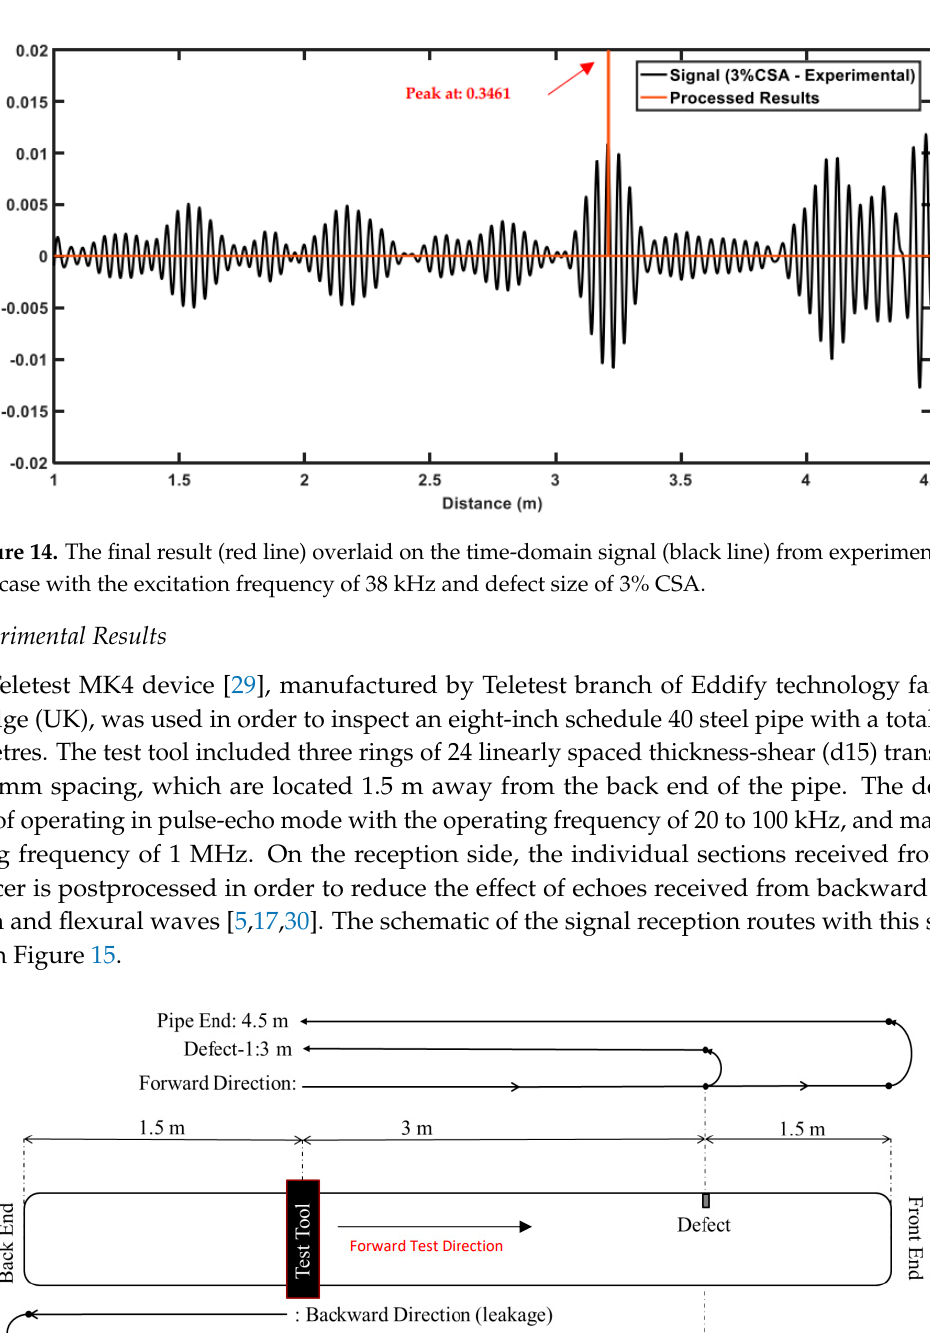
Figure 14. The final result (red line) overlaid on the time-domain signal (black line) from experimental test case with the excitation frequency of 38 kHz and defect size of 3% CSA.